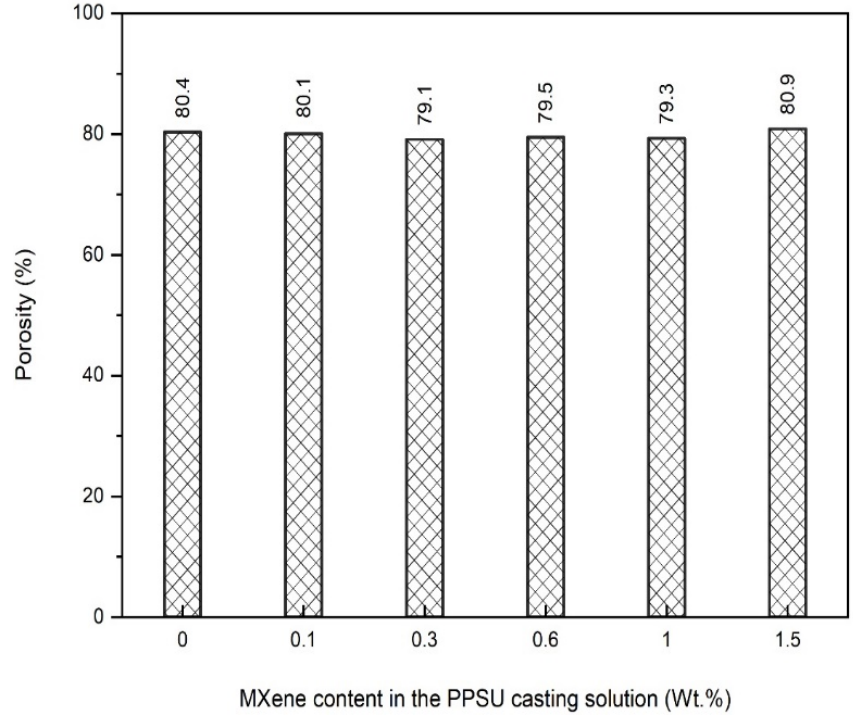
Figure 9. Porosity measurements of the NF nanocomposite